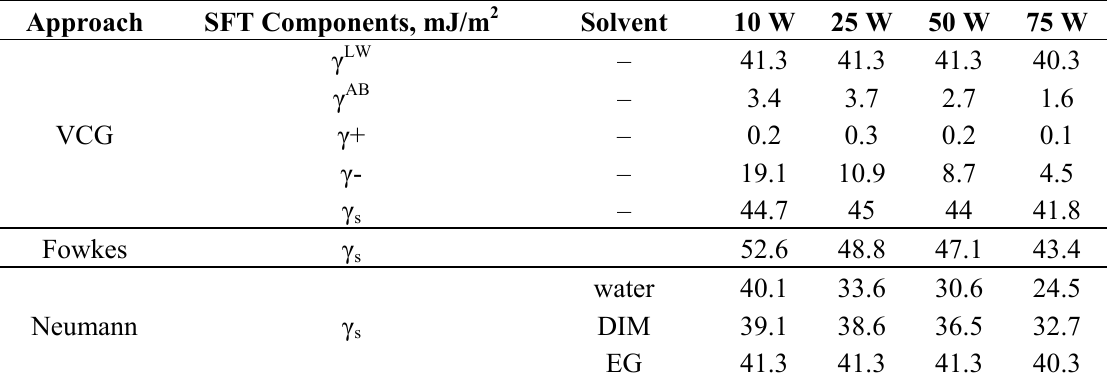
Table 7. The surface tension (SFT) components obtained via VCG, Fowkes and Neumann’s approach for pp–GT thin